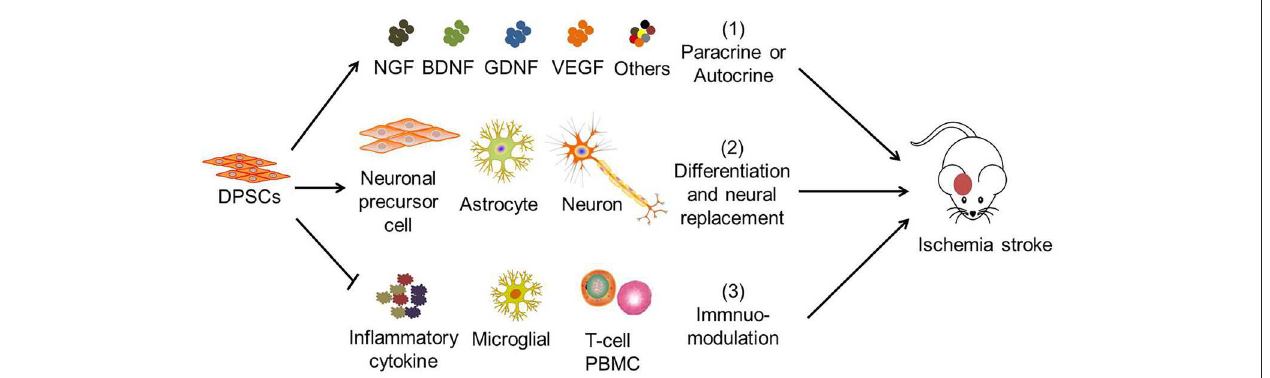
FIGURE 2 | The mechanisms of DPSC therapy for ischemic stroke. The therapeutic effects of DPSCs in stroke are attributed to (1) paracrine or autocrine production of cytokines and growth factors, (2) neural replacement through differentiation into neuronal progenitor cells, astrocytes and neuron-like cells, (3) immuno-modulation with mitigation of pro-inflammatory cytokine expression, of microglial activation, inhibition of activated T-cell response, and peripheral blood mononuclear cell (PBMC) proliferation. (1) and (3) are believed to be the main therapeutic effects of DPSCs.